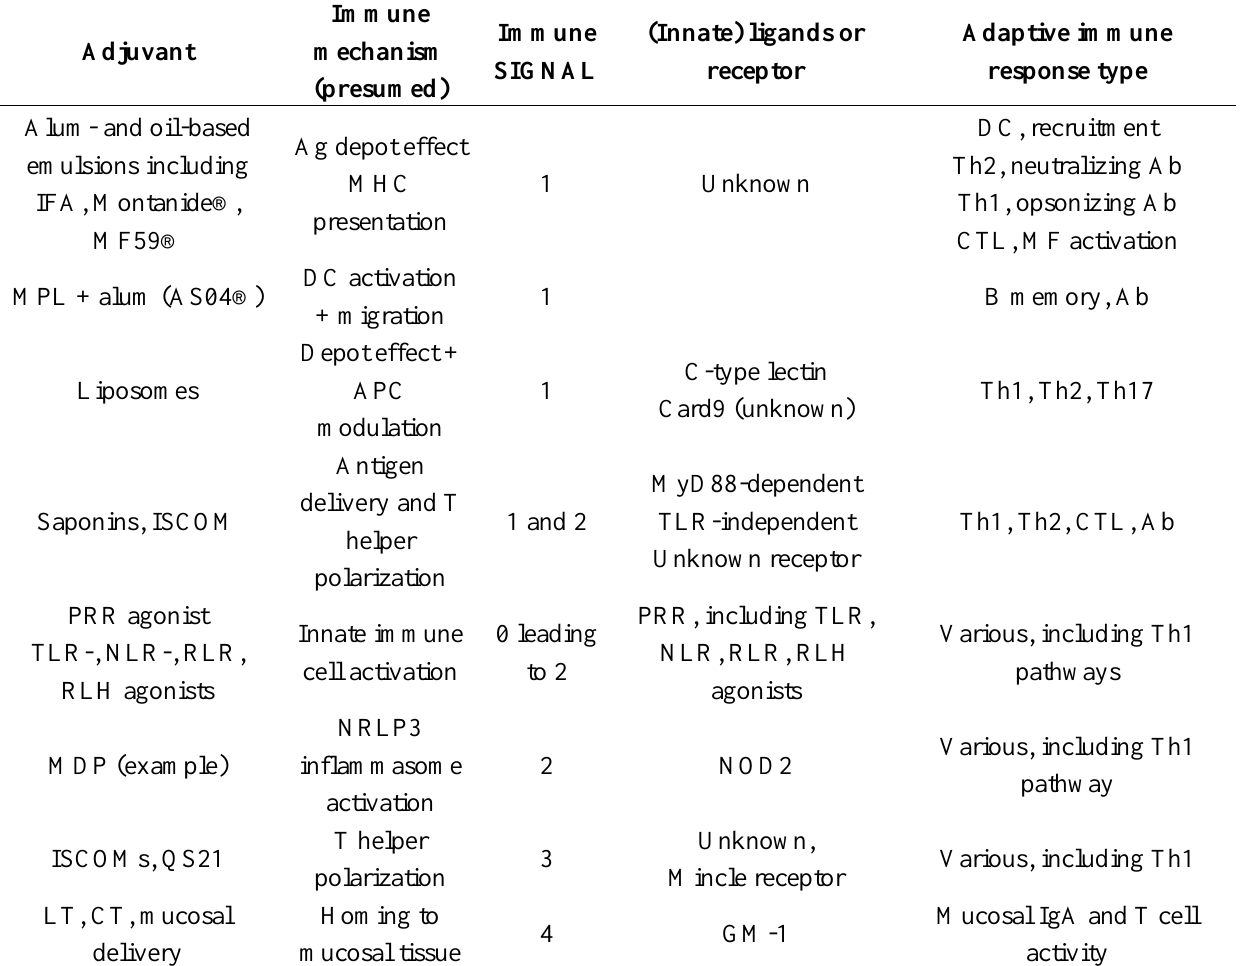
Table 1. Classes of well-known vaccine adjuvant types, their (expected) mode of action, related receptors and downstream immune pathways. IFA, incomplete Freund’s adjuvant; MPL, monophosphoryl lipid; MP59®, squalene-containing adjuvant; AS04®, adjuvant system 04; QS (QS-21) substance extracted from the bark of Quillaja saponaria ;